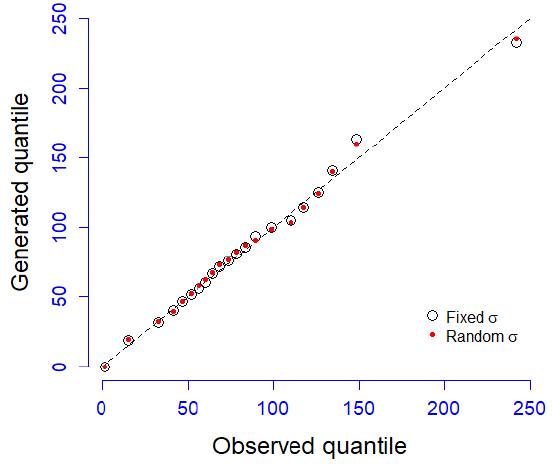
Figure 6. Quantile–quantile plot for observed and generated data.